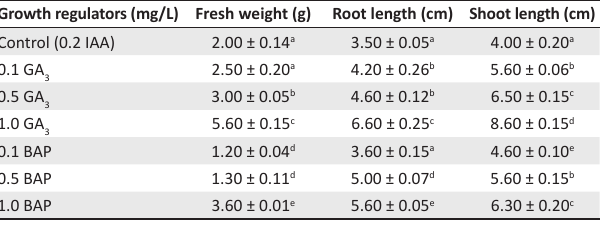
TABLE 2: Effect of different concentrations of gibberellic acid and benzyl aminopurine in combination with indole acetic acid in Murashige and Skoog medium on fresh weight.